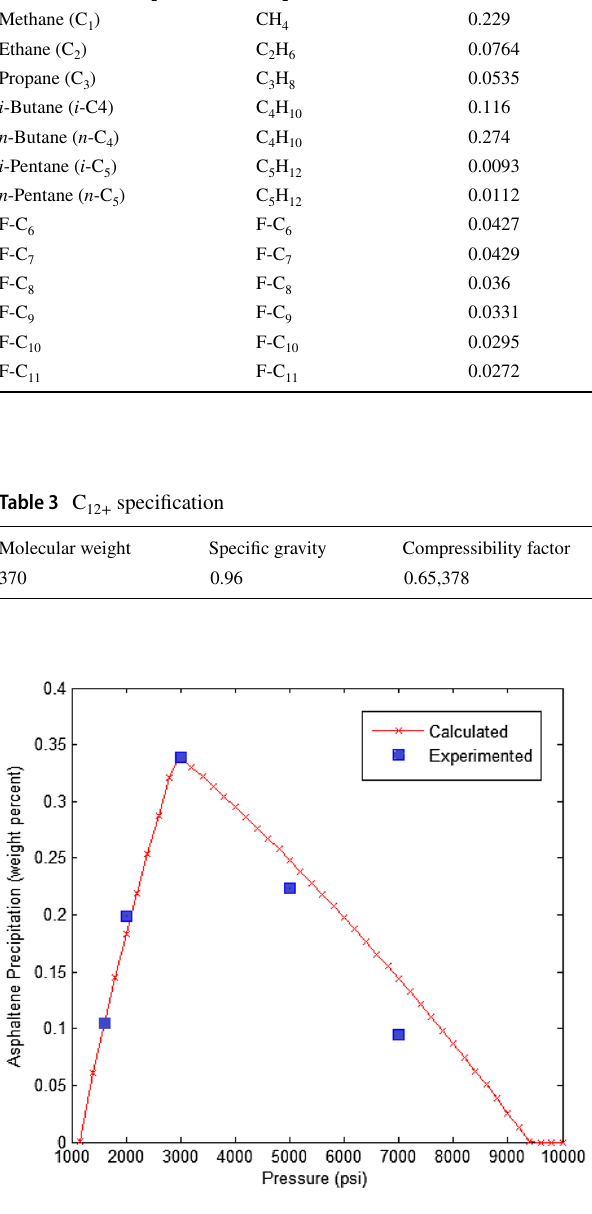
Fig. 2 Comparison of solid model results with experimental data of asphaltene precipitation at 220